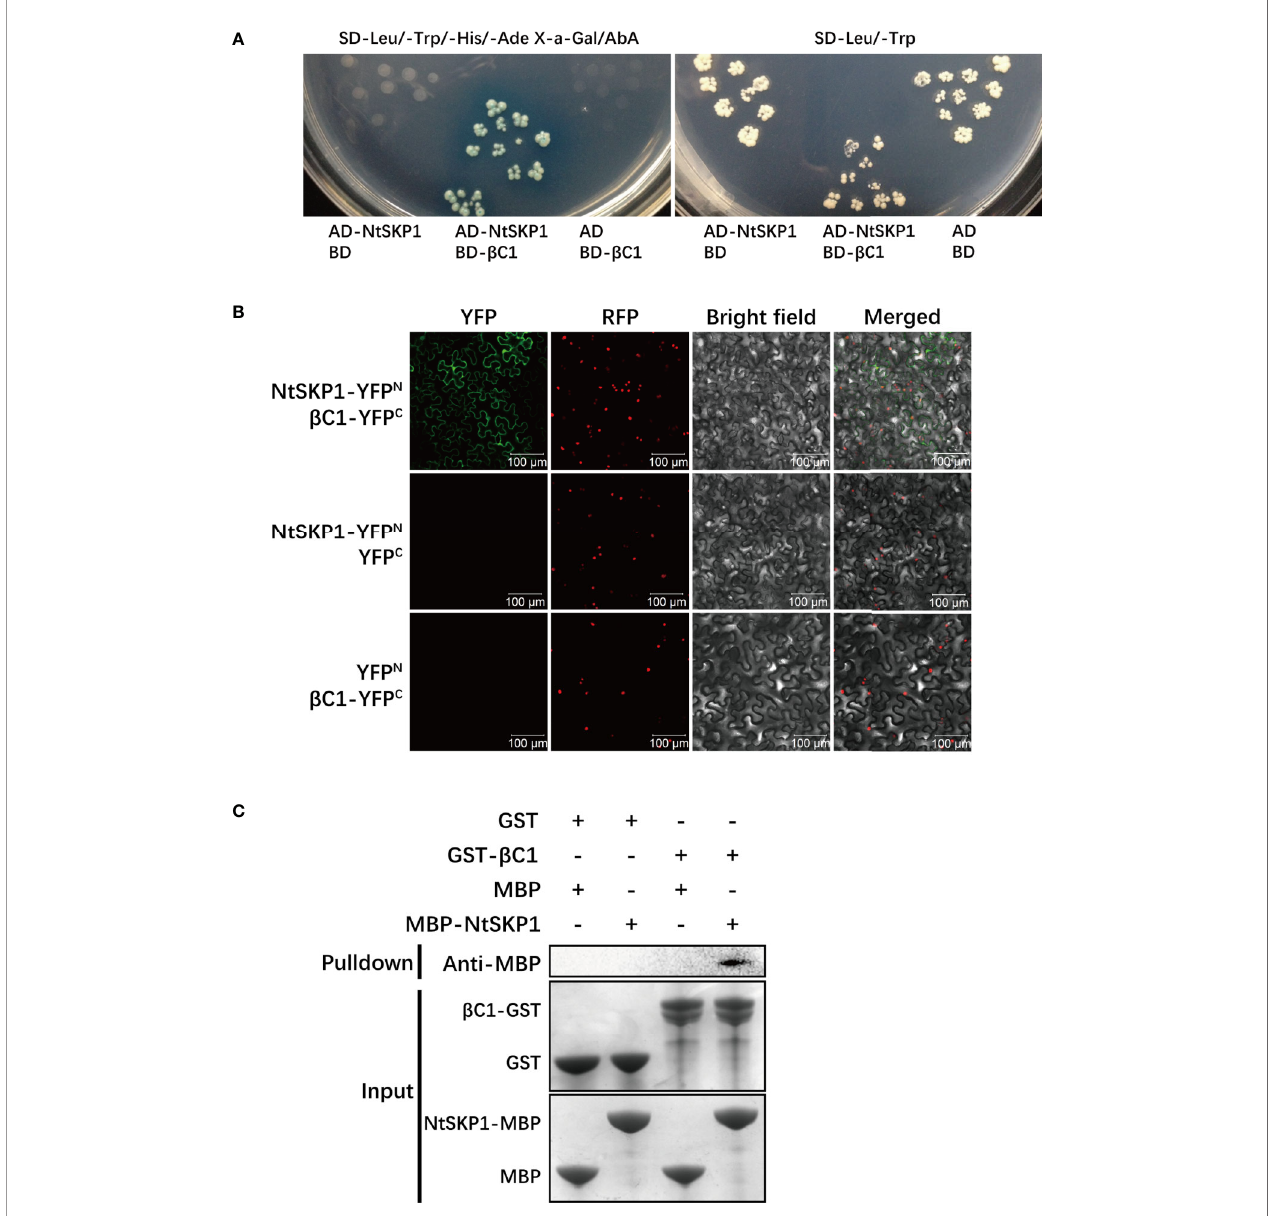
FIGURE 1 | The interaction between b C1 and NtSKP1. (A) Interaction con fi rmation of b C1 and NtSBT1.7 via yeast two-hybrid system. Yeast strain Y2H Gold co- transformed indicated plasmids were grown on SD-Leu/-Trp/-His/-Ade X-a-Gal/AbA and SD-Leu/-Trp. Empty plasmids pGADT7/pGBKT7 were used as negative controls. (B) In vivo interaction con fi rmation of b C1 and NtSBT1.7 via BiFC analysis. b C1-YFP C and NtSKP1-YFP N were transiently co-expressed in N. benthamiana line H2B-RFP, of which nucleus were marked with RFP fusion protein. Photos were imaged at 48 h using a Zeiss LSM710 confocal microscope. Columns from left to right represent YFP fl uorescence, RFP fl uorescence, bright fi eld, and YFP/RFP/bright fi eld overlay. Empty plasmids were negative controls. Scale bars 100 m m. (C) In vitro interaction con fi rmation of b C1 and NtSBT1.7 via GST pull-down assay. Protein GST, b C1-GST, MBP, NtSKP1-MBP were expressed by prokaryotic expression, and puri fi ed by Glutathione agarose beads or Amylose resin. GST or GST- b C1 fusion proteins were used to pulldown MBP or MBP-NtSKP1 fusion proteins. Binding proteins were analyzed via SDS-PAGE and western blot assays using anti-MBP antibodies. At the start of Samples (Input) were stained by Coomassie blue solution. GST, MBP proteins were used as negative